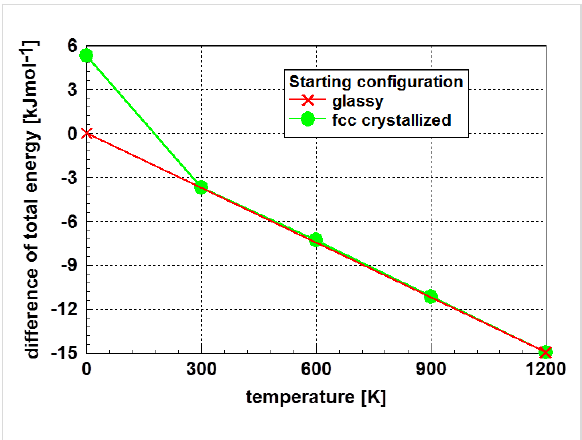
Figure 5: Total energy of the originally crystalline Au 55 cluster as a function of the temperature, relative to the glassy state at 0 K. It is obvious, the phase transformation of the non-equilibrium originally fcc crystalline cluster to the stable glassy one occurs in the temperature range between 0 and 300